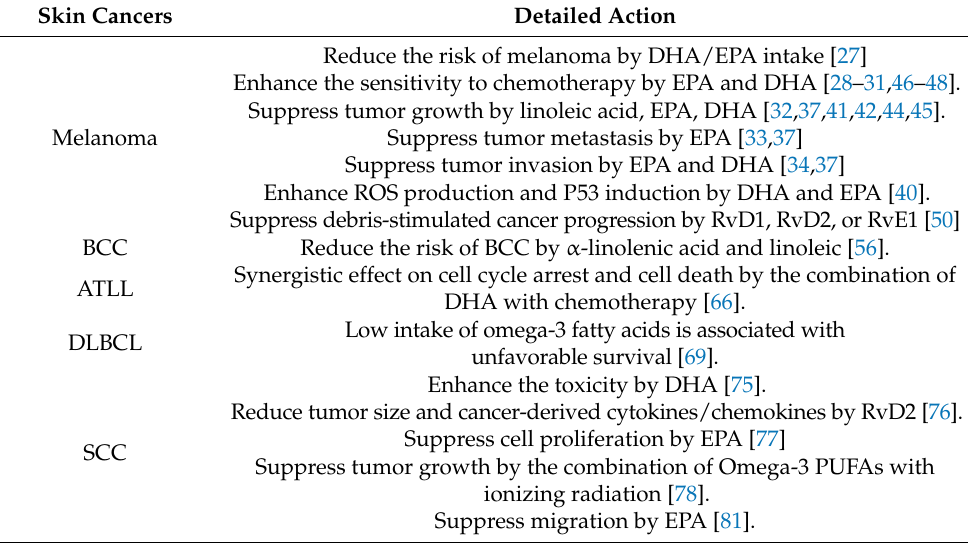
Table 1. Summary of detailed action of omega-3 PUFAs against skin